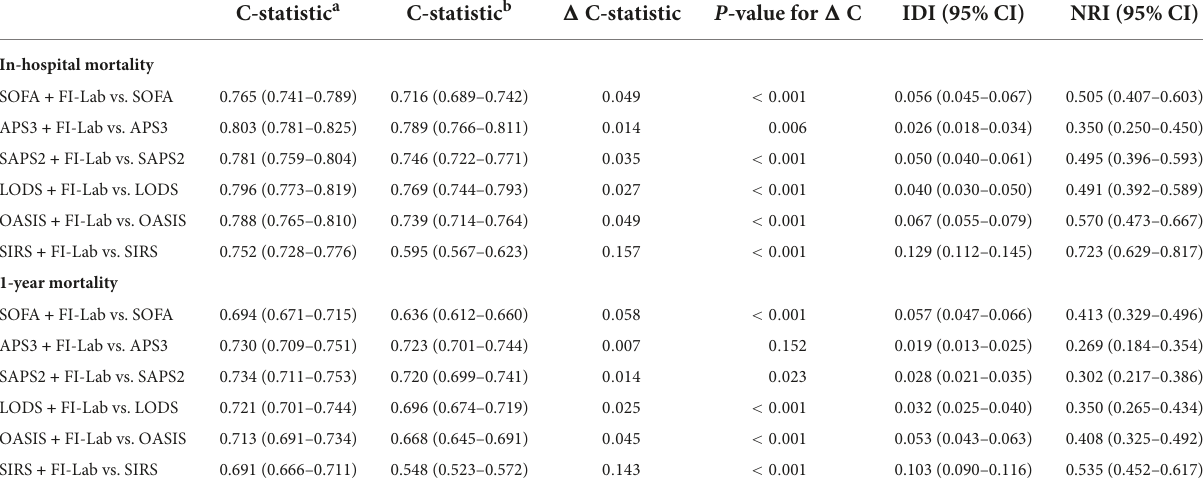
TABLE 4 Incremental value of frailty index based on laboratory tests (FI-Lab) for in-hospital and 1-year mortality. C-statistic